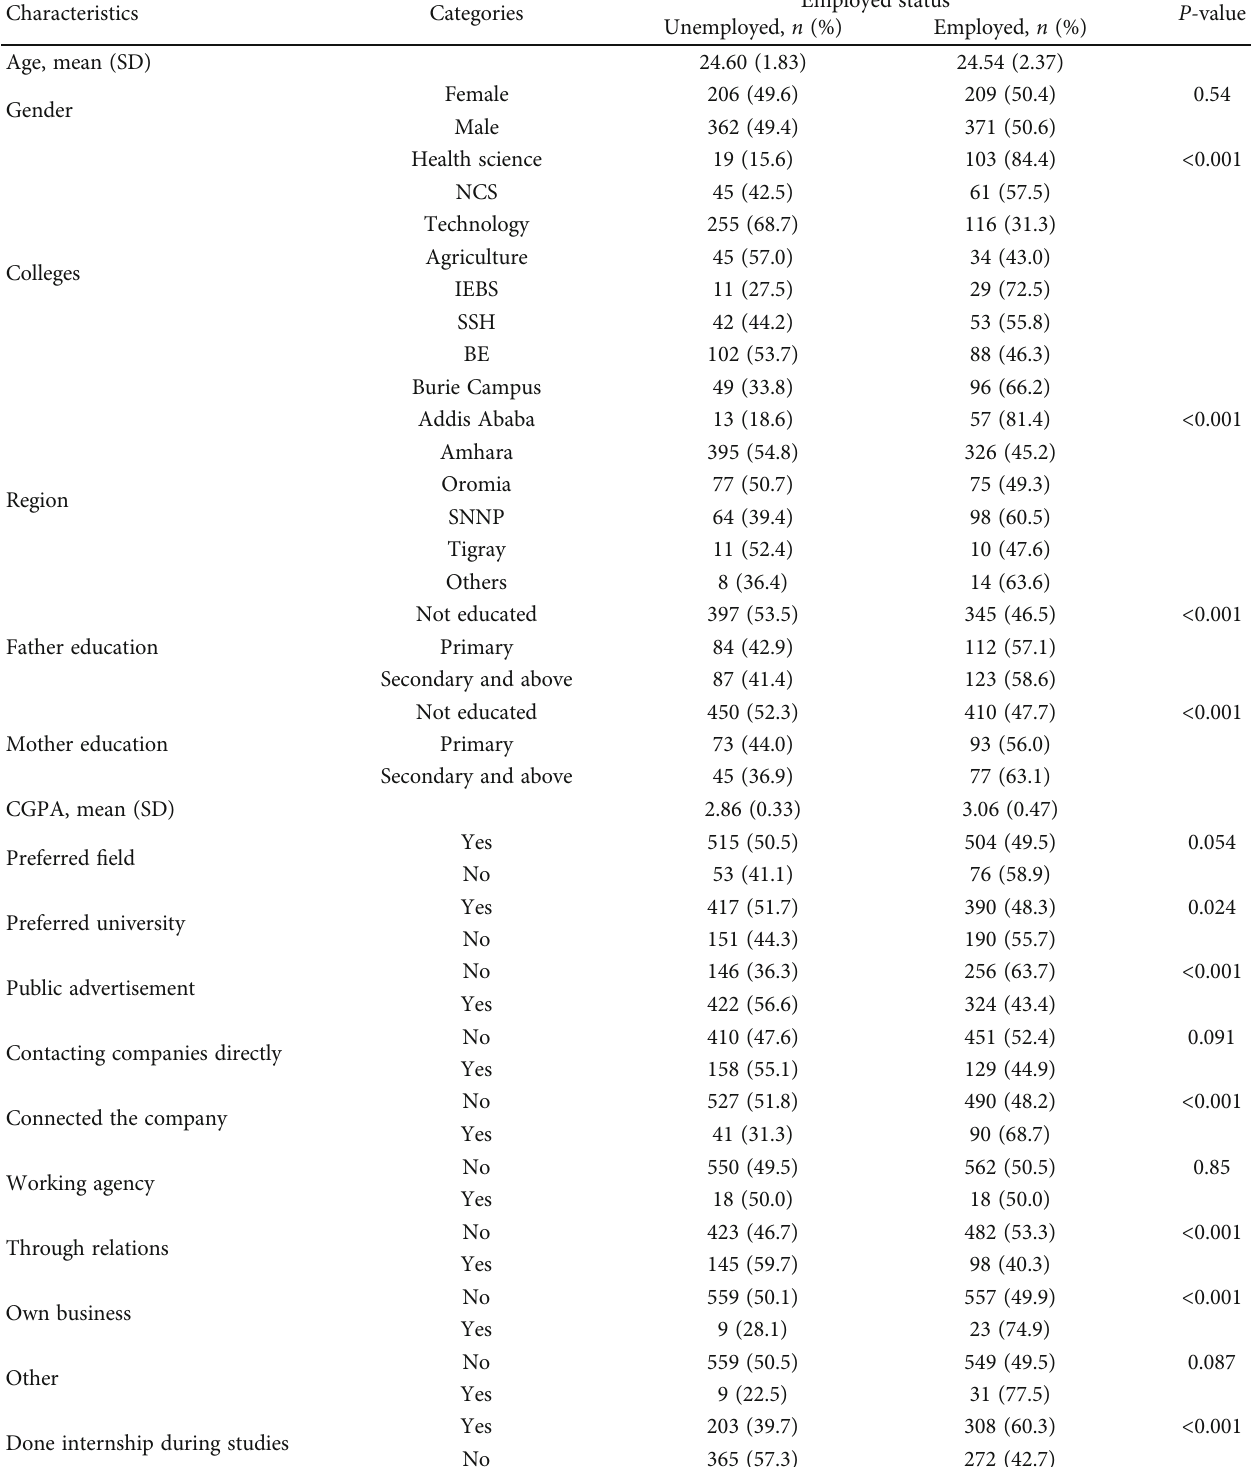
Table 1: Employment status of Debre Markos University 2019 graduates by their characteristics and the log-rank test of equality of survivor function p